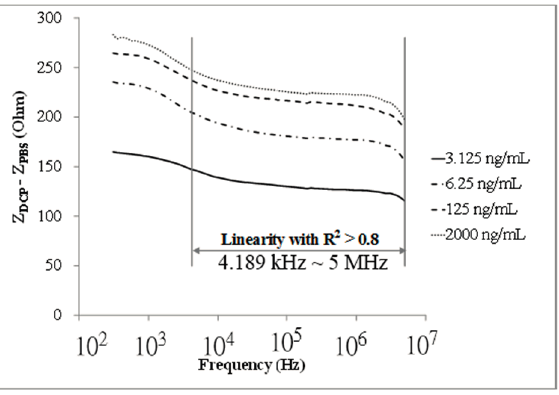
Figure 2. The impedance (Z) response of the immunosensor to DCP at various concentrations (3.125, 6.25, 125, 2000 ng/mL) within a frequency range of 300–5 MHz.